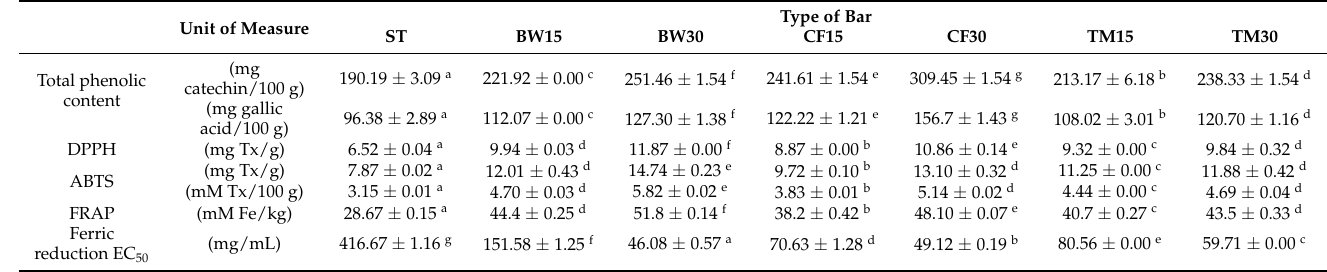
Table 5. Content of polyphenols and antioxidant activity of edible insect